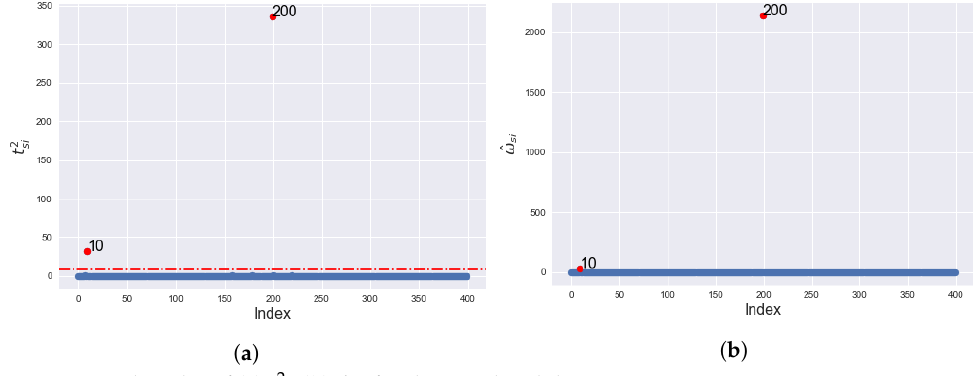
, ( b ) ˆ ω si for the simulated si